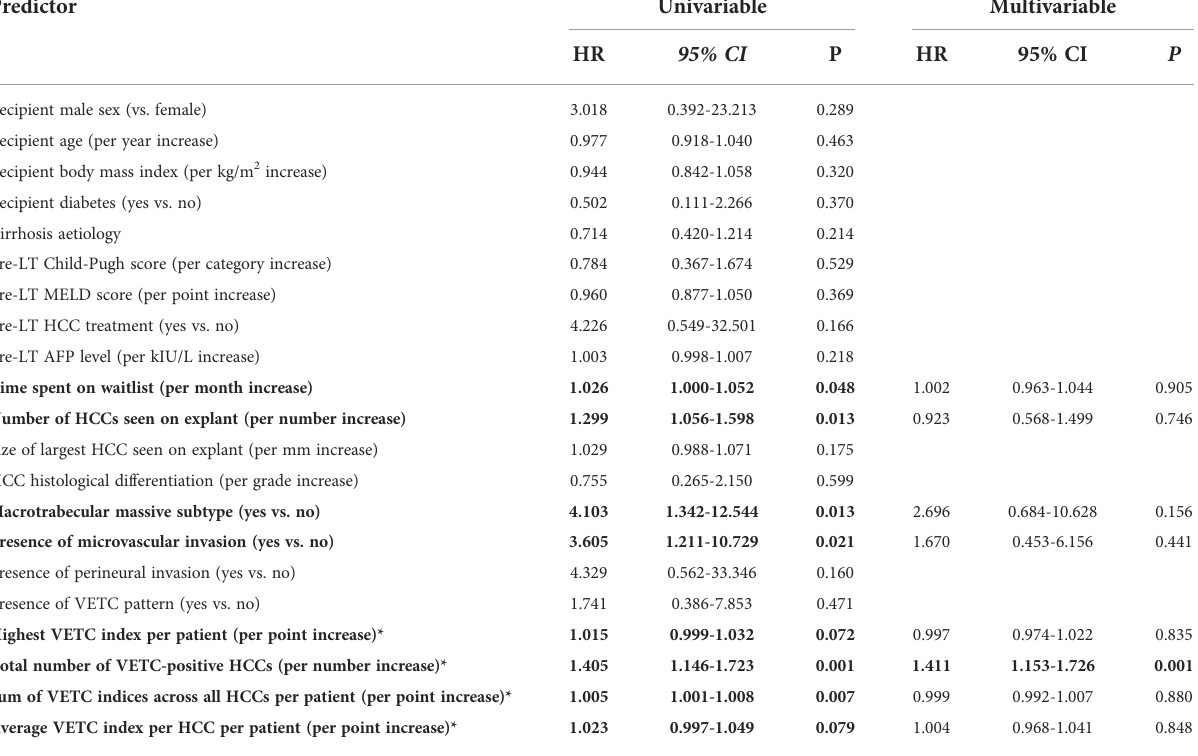
TABLE 3 Univariable and multivariable predictors of HCC recurrence (Time to recurrence).